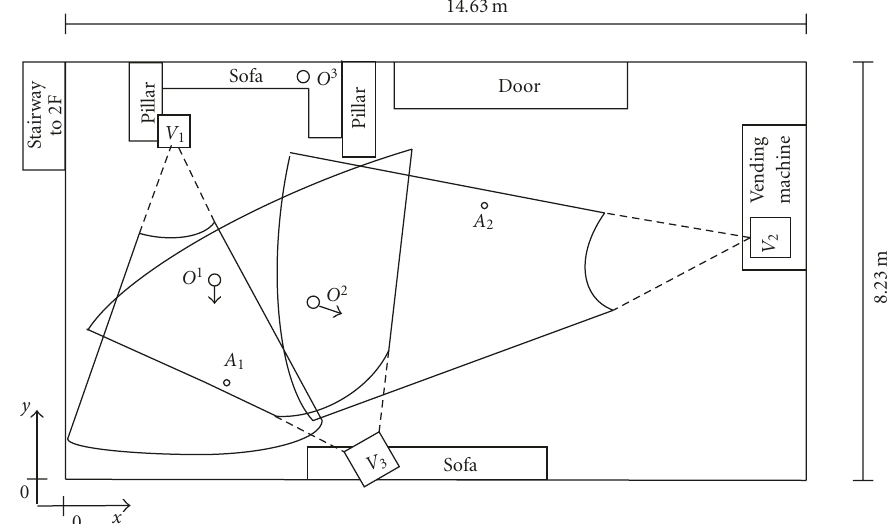
Figure 14: The visual sensor cooperation with an acoustic sensor-based estimation is experimented in an indoor environment with size 14 . 63m × 8 . 23m.